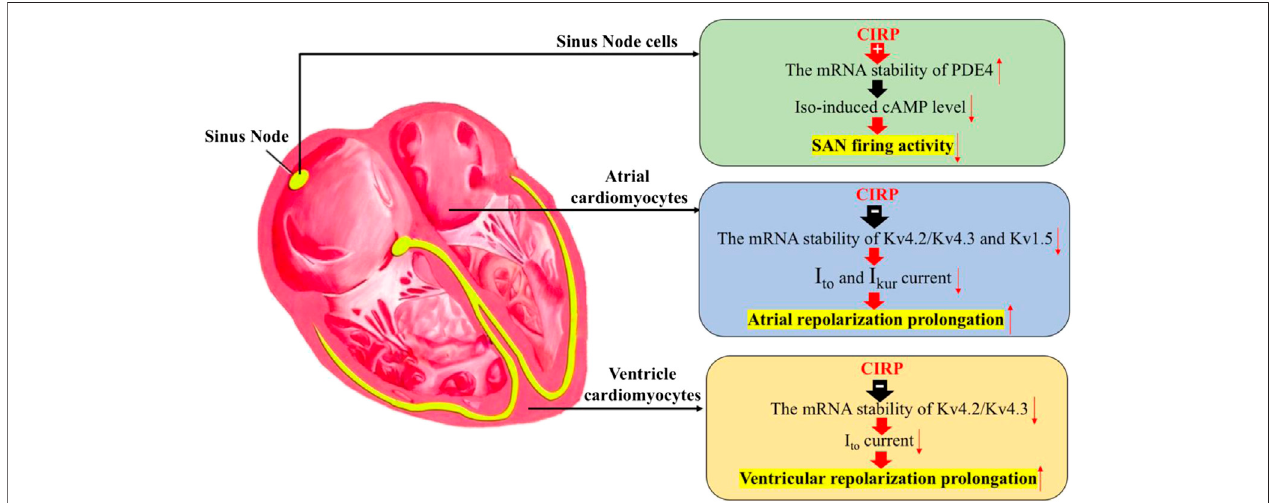
FIGURE 1| The effects ofCIRP in cardiac electrophysiology. Firstly, CIRP can suppress the fi ring activity ofthe sinus atrial node (SAN) cells by positively regulating the mRNA stability of PDE4, which is the key enzyme for the degradation of the isoprenaline-induced cAMP level. Secondly, CIRP can delay the atrial repolarization by negatively in fl uencing the mRNA stability of Kv4.2/Kv4.3 and Kv1.5, which codes for the repolarization current of I to and I Kur . Thirdly, CIRP can delay the ventricle repolarization by negatively in fl uencing the mRNA stability of Kv4.2/Kv4.3, which codes for the repolarization current of I to . PDE4: phosphodiesterase four; Iso: